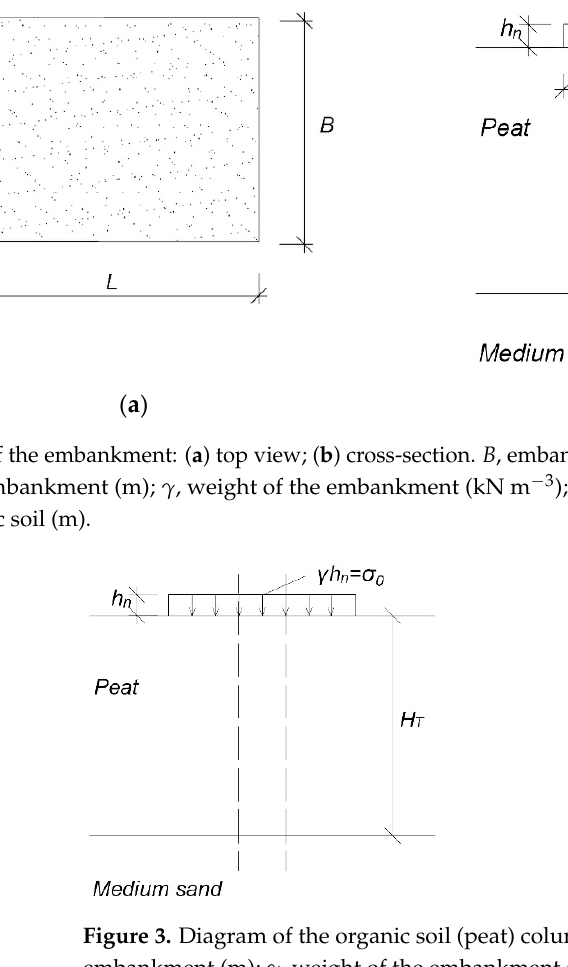
Figure 3. Diagram of the organic soil (peat) column in a separate calculation area; h n , height of the embankment (m); γ , weight of the embankment (kN m − 3 ); σ 0 , loaded with the embankment (kPa); H T , thickness of the organic soil (m).